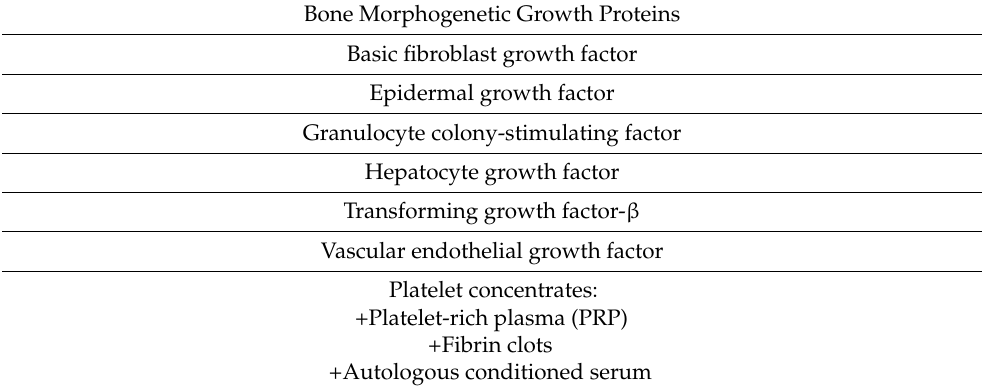
Table 1. Growth factors used in anterior cruciate ligament